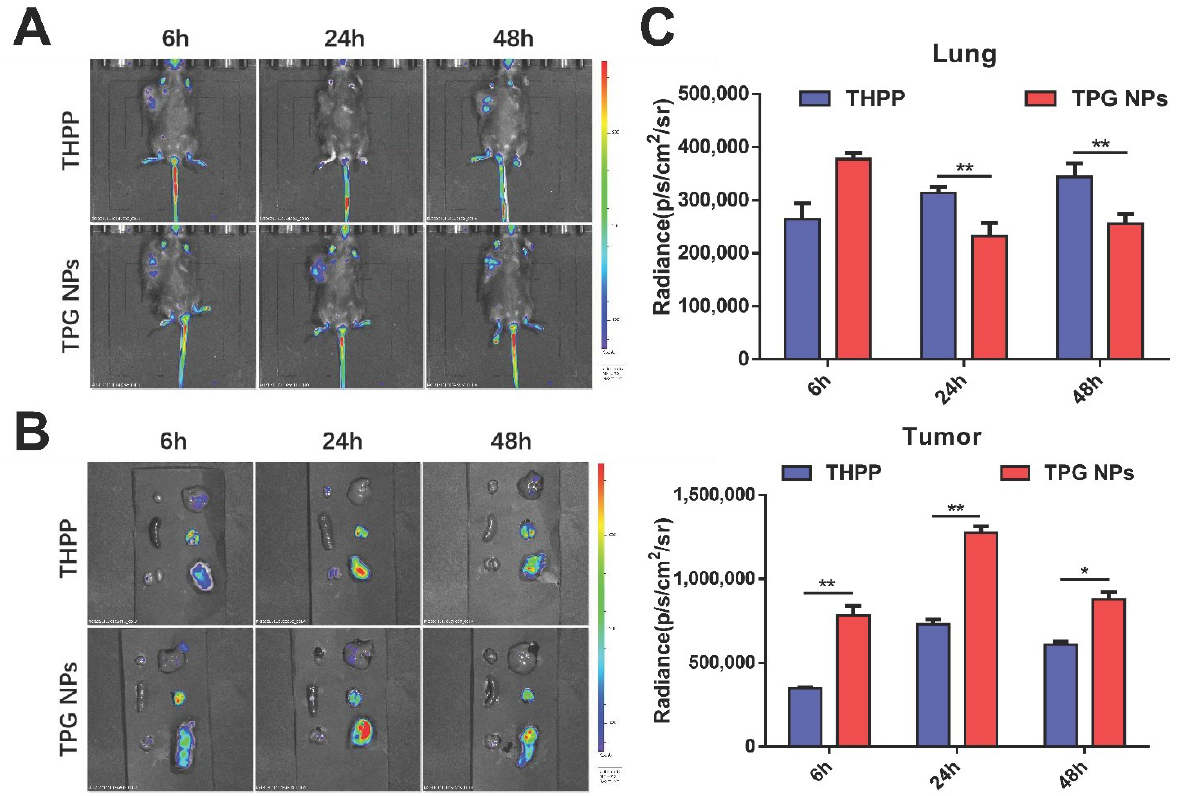
Figure 6. Biodistribution of TPG NPs in vivo. IVIS images ( A , B ) and the quantitative data ( C ) of C57BL/6 mice treated with different formulations for 6–48 h (Data represent the mean ± SD of three independent experiments. * p < 0.05, ** p < 0.01). Images were captured by monitoring the THPP signal, and the organs in ( B ) were arranged as heart and liver (first line), spleen and lung (second line), and kidney and tumor (third line).